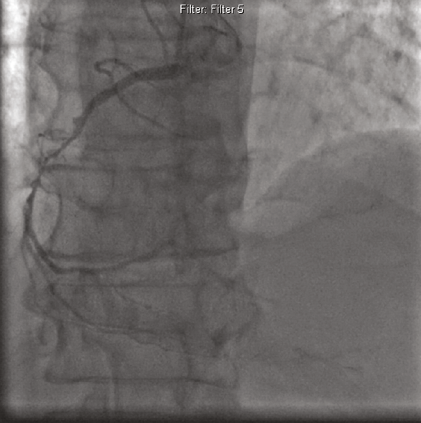
Figure 1: Right coronary artery with severe stenosis.